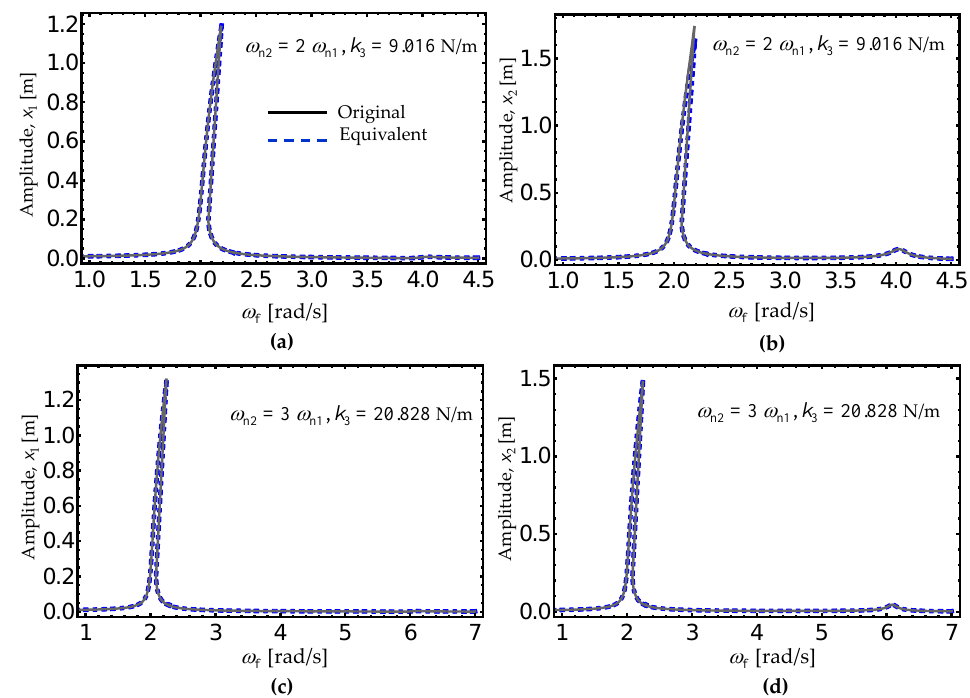
Figure 12. Frequency-amplitude response curves computed from the numerical integration solutions of Equations (29) and (43) when subjected to internal resonances. Internal resonance of the type ω n 2 = 2 ω n 1 , ( a ) x 1 vs ω f , ( b ) x 2 vs ω f with k 3 = 9.016 N/m. Internal resonance of the type, ω n 2 = 3 ω n 1 , ( c ) x 1 vs ω f , ( d ) x 2 vs ω f with k 3 = 20.828 N/m. The parameter values used to obtain these plots were m 1 = 10 kg, m 2 = 0.6 kg, c 1 = 0.1 Ns/m, c 2 = 0.08 Ns/m, k 1 = 44 N/m, k 2 = 8 N/m 3 , k 4 = − 0.65 N/m 3 , and f 0 = 0.37 N. Here, the black, solid lines describe the numerical integration solution of Equation (43), while the blue, dashed lines describe the numerical solutions obtained from the derived equivalent nonlinear equations of motion (29).